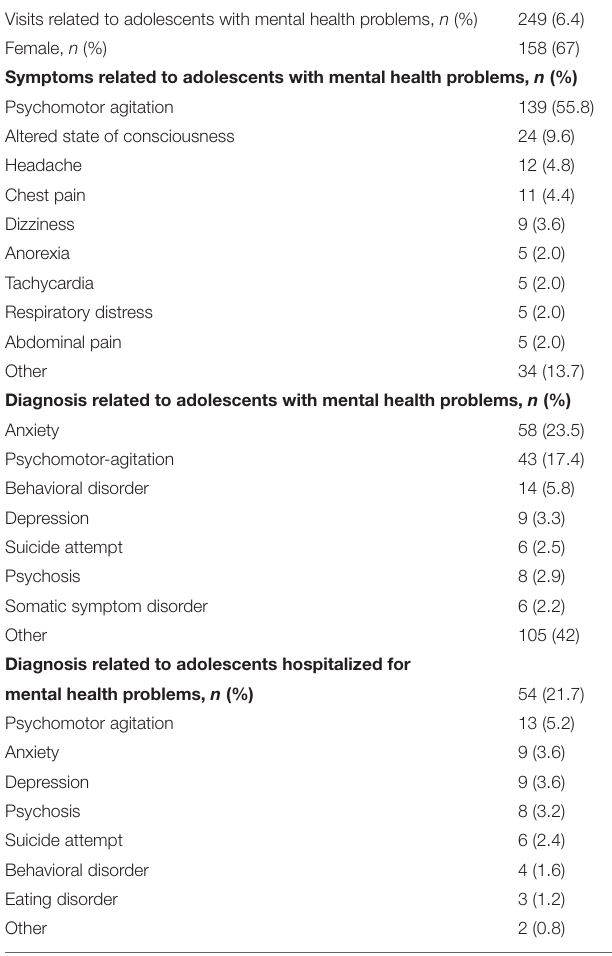
TABLE 2 | Main characteristic of adolescents accessing the PED for mental health problems. Visits related to adolescents with mental health problems, n (%) 249